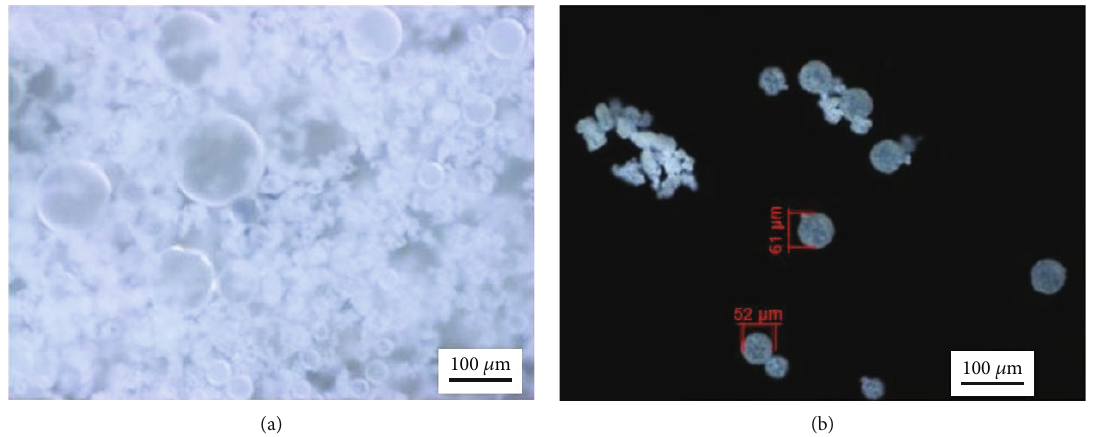
Figure 2: Optical microscopy images of tung oil microcapsules (a) raw material and (b) microcapsules after washing.